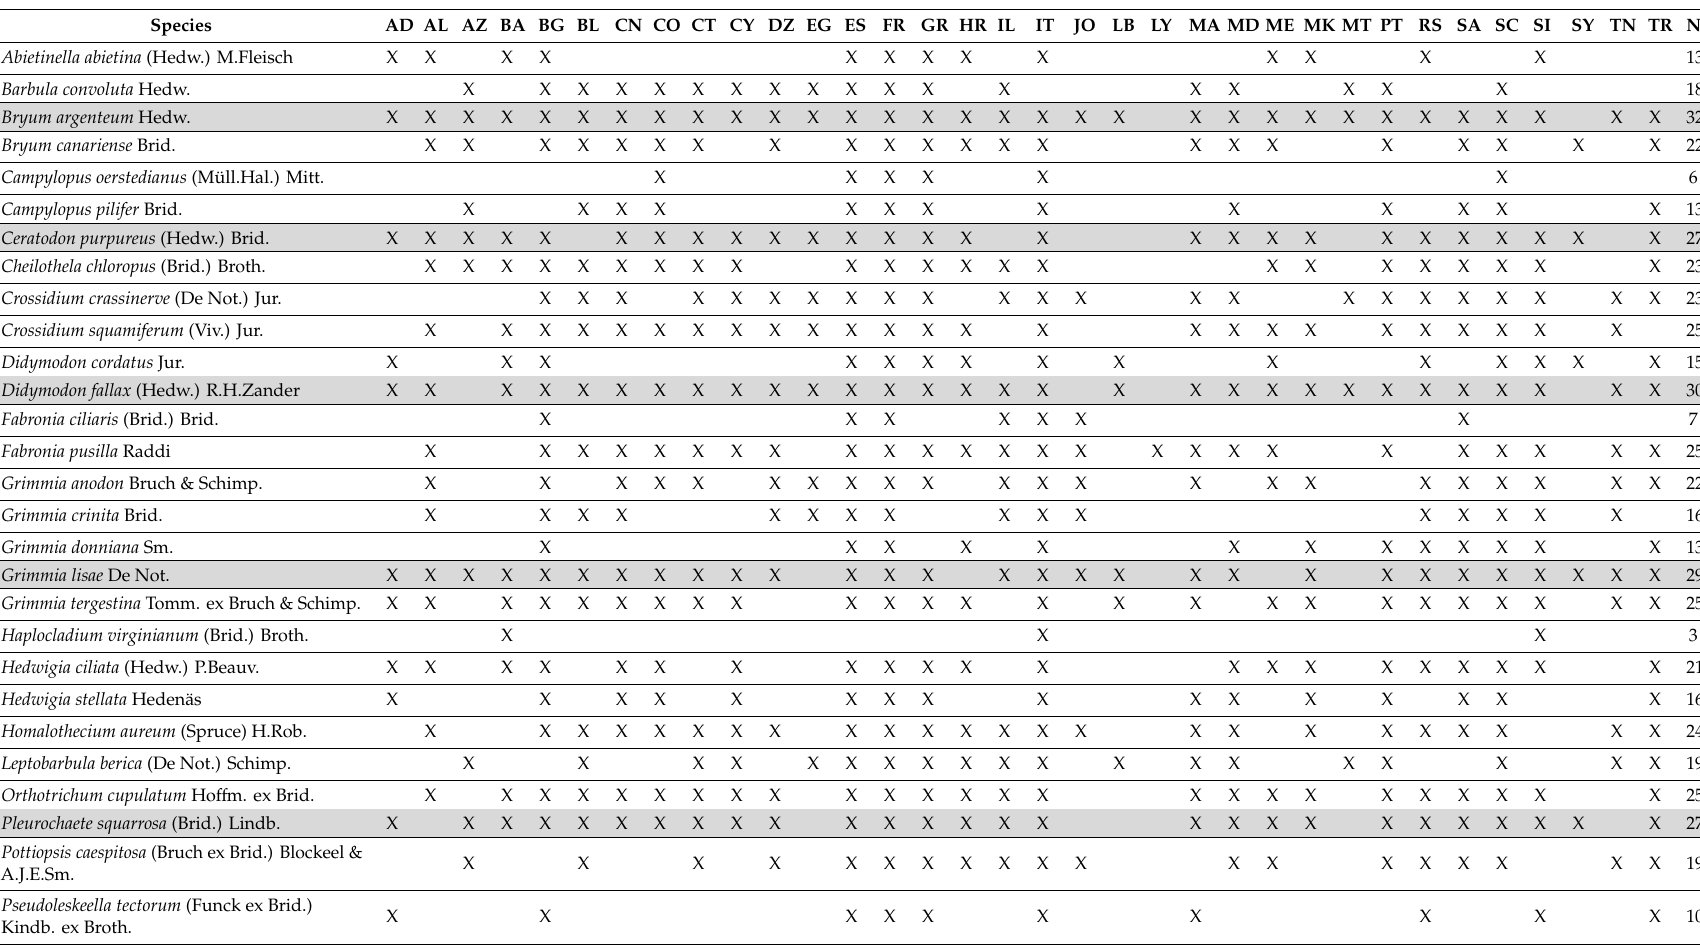
Table 2. Countries or regions according to Ros and co-workers [33]. The most common moss species are highlighted in grey (present in more than 27 countries [80%]). (Countries abbreviation AD: Andorra; AL: Albania; AZ: Azores; BA: Bosnia-Herzegovina; BG: Bulgaria; BL: Baleares; CN: Canary Islands; CO: Corsica; CT: Crete; CY: Cyprus; DZ: Algeria; EG: Egypt; ES: Spain; FR: France; GR: Greece; HR: Croatia; IL: Israel; IT: Italia; JO: Jordan; LB: Lebanon; LY: Libya; MA: Morocco; MD: Madeira; ME: Montenegro; MK: Macedonia; MT: Malta; PT: Portugal; RS: Serbia; SA: Sardinia; SC: Sicily; SI: Slovenia; SY: Syria; TN: Tunisia; TR: Turkey.) Species Abietinella abietina (Hedw.) M.Fleisch Barbula convoluta Hedw. Bryum argenteum Hedw. 32 Bryum canariense Brid. Campylopus oerstedianus (Müll.Hal.) Mitt. X X X Campylopus pilifer